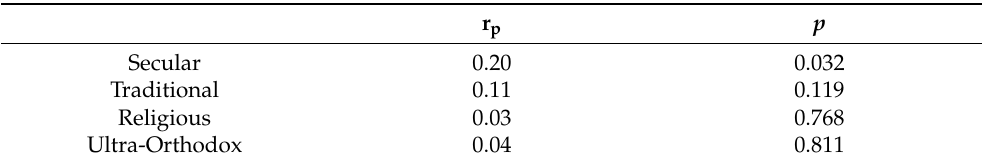
Table 2. The association between altruism and willingness to donate/sign an organ donor card in each category of